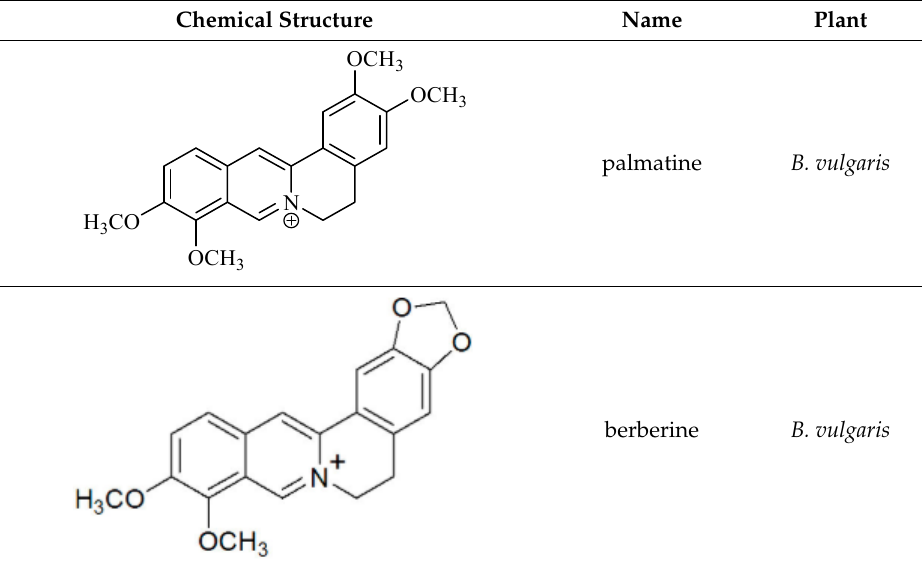
Table 1. Alkaloids from Berberis species.